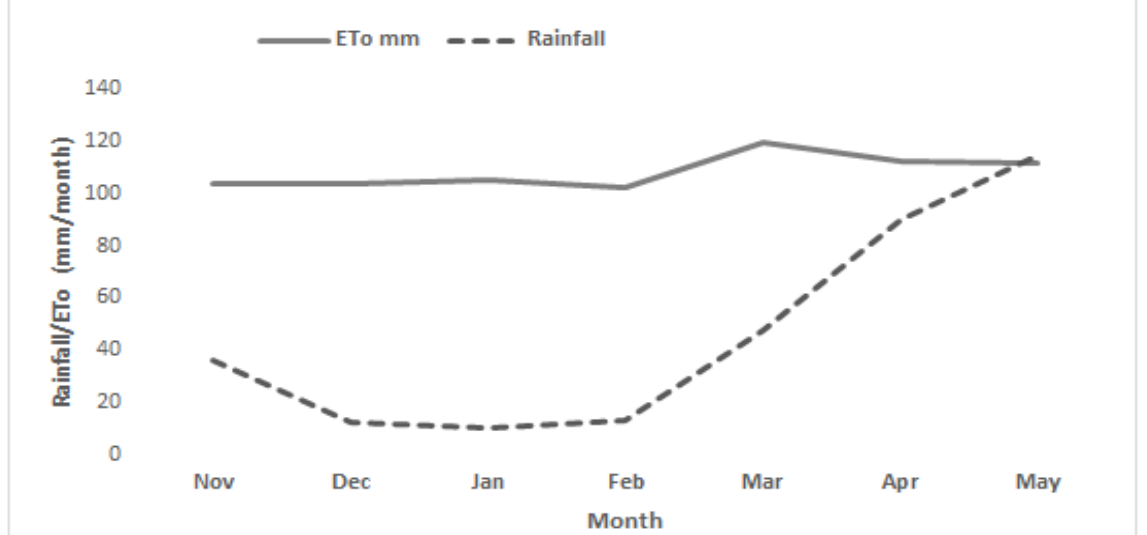
Figure 5. Mean monthly ET o and rainfall in the irrigation season.